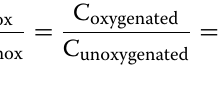
Table 1 [23]. O1s energy level spectra were fitted with two peaks with a fixed separation of 2 eV. Two samples of each wood were measured and a mean with standard deviation were calculated.